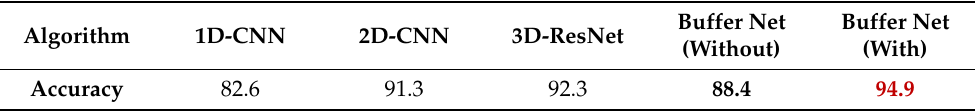
Table 2. The comparison of the differentiation accuracy for all samples.